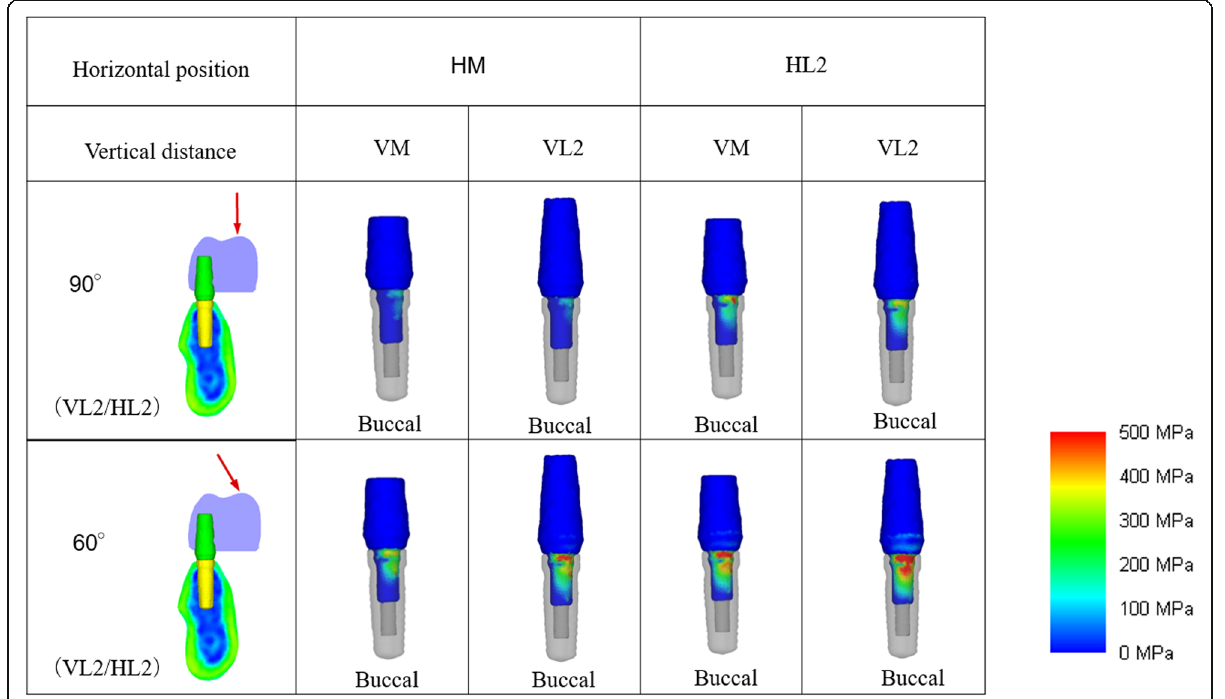
Fig. 13 Distribution of the stress in the abutments of each